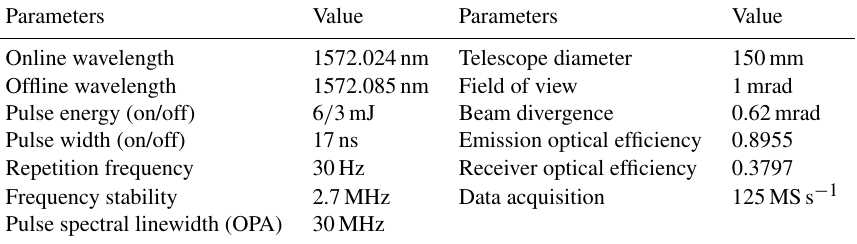
Table 1. The main parameters of the airborne dual-wavelength IPDA lidar system (OPA represents optical parametric amplification). Parameters